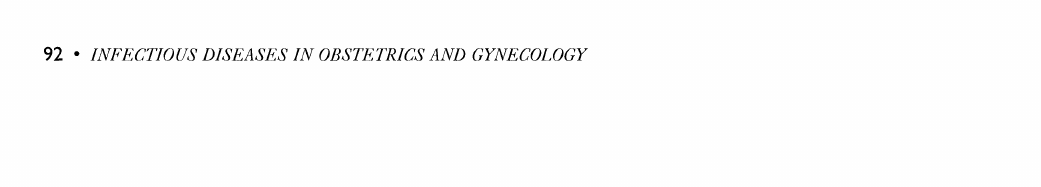
aWith 95% confidence intervals; adjustment using logistic regression. bNo surgery. not change appreciably from those obtained when use was defined simply from